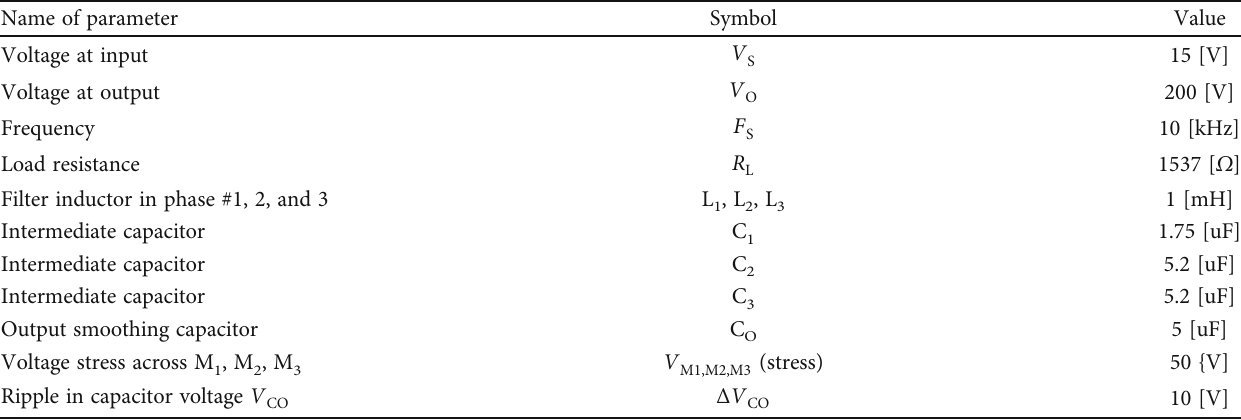
Figure 7: State VI. Table 1: Converter parameters for